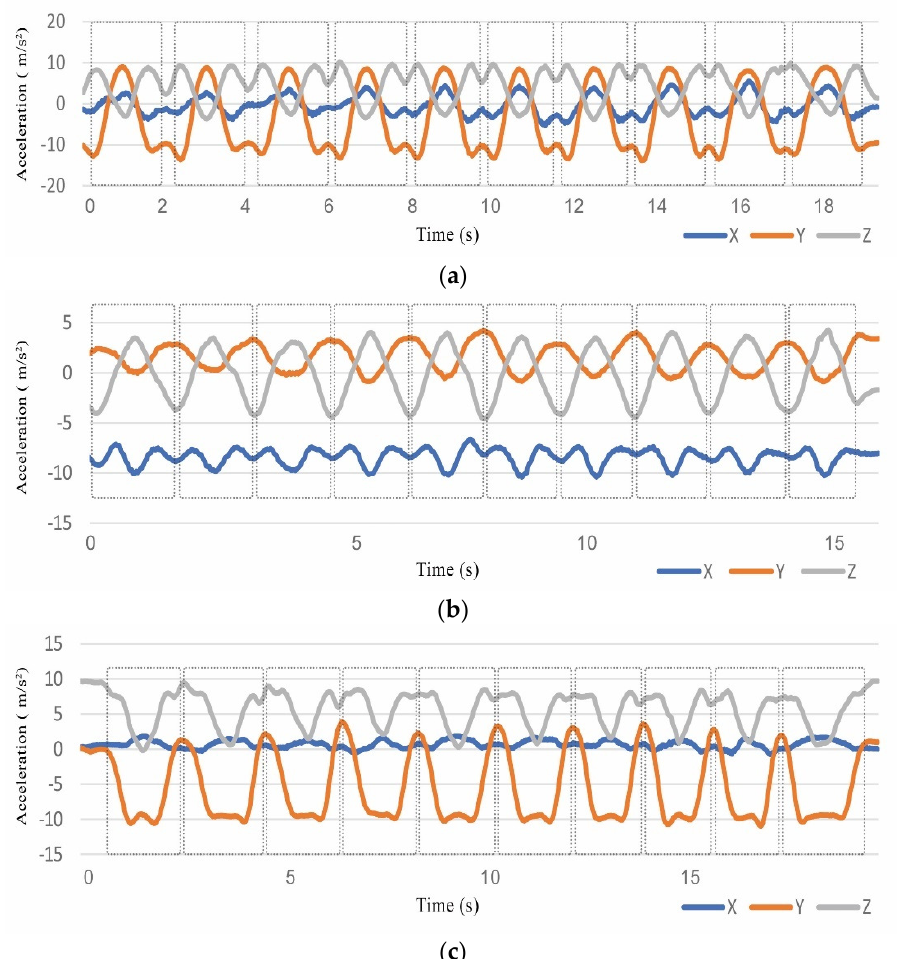
Figure 3. Acceleration signal for 10 repetitions of ( a ) Abduction, ( b ) Internal rotation (IR), and ( c ) Extension.